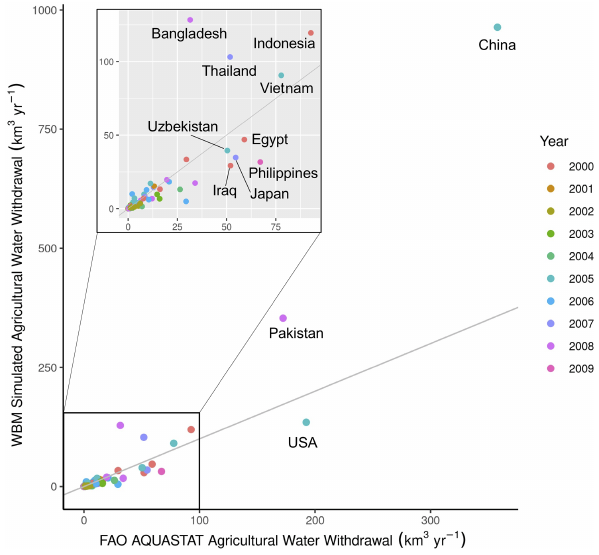
Figure 6. WBM-simulated irrigation water withdrawals compared to FAO AQUASTAT-reported values, by country. The 1 : 1 line is shown in gray. Countries with FAO-reported agricultural water withdrawals < 100km 3 yr − 1 are shown in the inset. Countries with FAO-reported agricultural water withdrawals > 50km 3 yr − 1 are la-